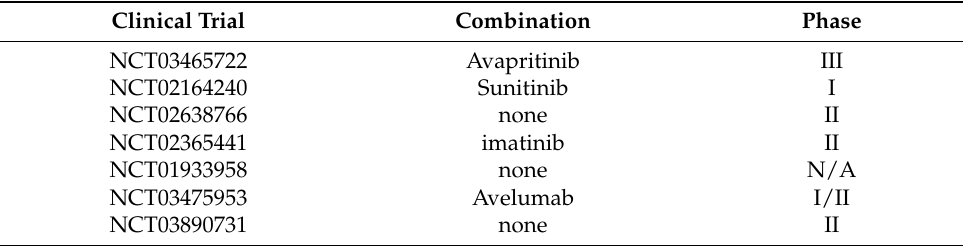
Table 5. Regorafenib ongoing clinical